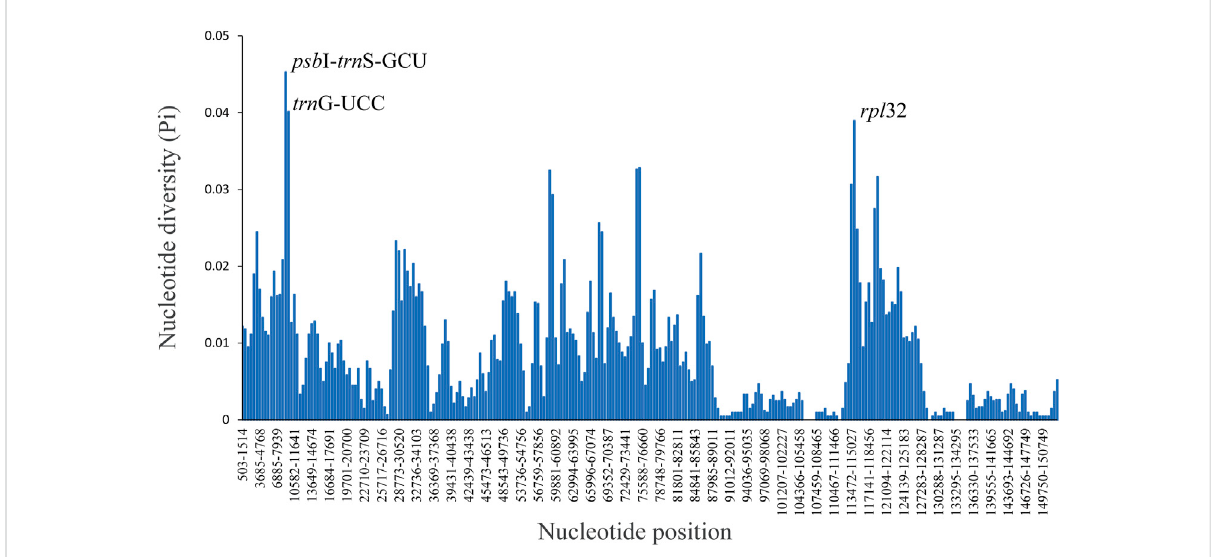
FIGURE 5 Nucleotide diversity (Pi) in the complete plastid genomes of four species of Renanthera . Window length: 1,000 bp, step size: 500 bp.